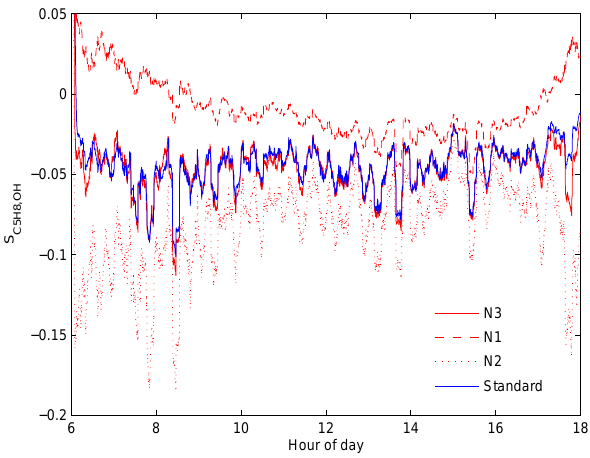
Fig. 9. The effect of heterogeneous NO concentrations correlated with those of isoprene (N1, red dashes), anti-correlated with those of isoprene (N2, red dots), and showing no correlation with iso- prene (N3, red line), compared with a standard run (blue line) for a randomly-generated isoprene